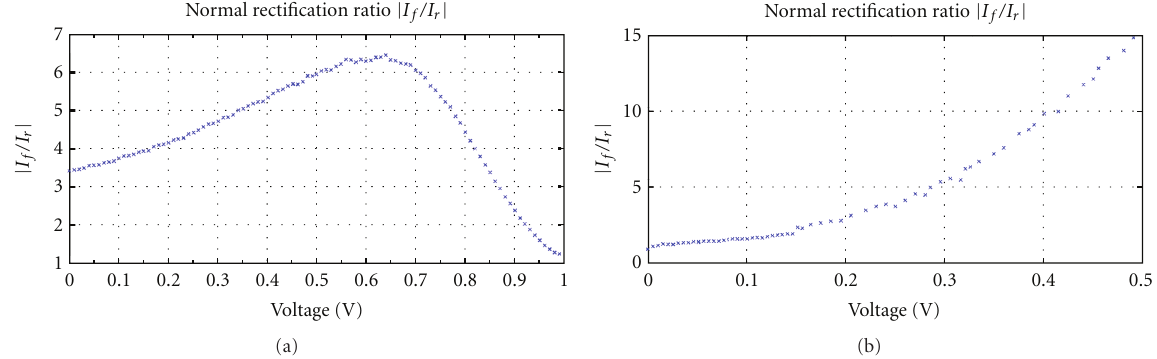
Figure 7: Rectification ratios | I f /I r | plotted versus absolute value of voltages for (a) native oxide and (b) plasma oxide.